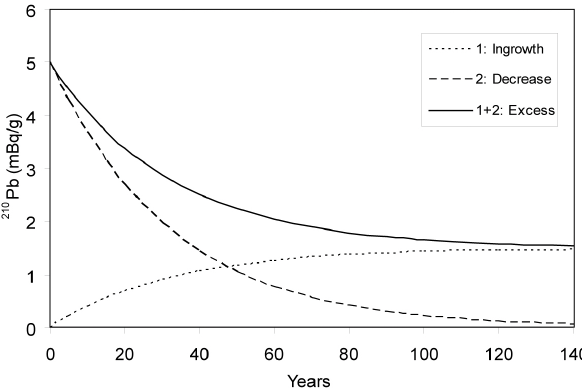
Fig. 6. Theoretical evolution of 210 Pb activity as a function of time for the decrease (1), ingrowth (2) and excess model (1+2). The excess model is the sum of decrease and ingrowth